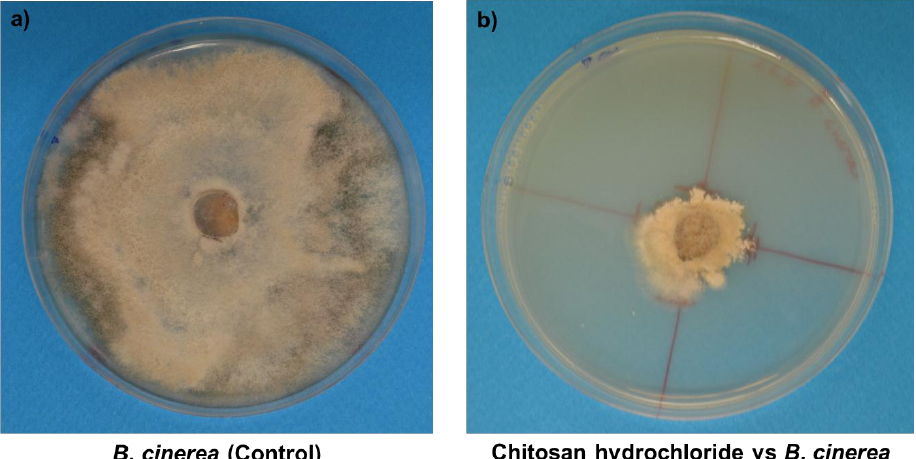
Figure 6. In vitro results after 7 days, with an evident inhibition of radial growth of B. cinerea by chitosan hydrochloride. Botrytis cinerea ( a ) and Chitosan hydrochloride vs Botrytis cinerea ( b ).